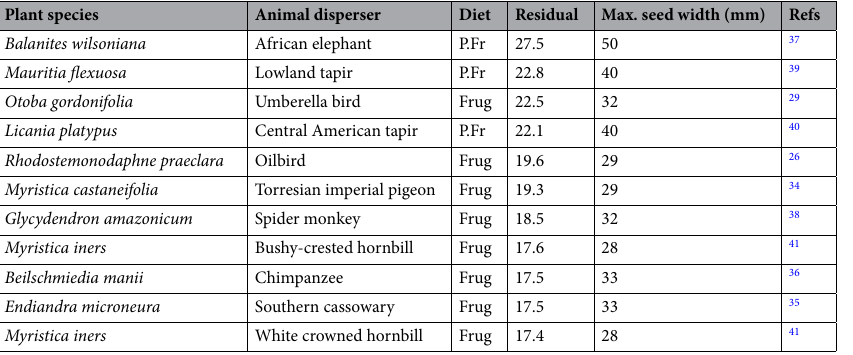
Figure. 2. Relationship between maximum width of endozoochorous dispersed seeds and the body weight of the disperser. ( A ) Whole dataset indicating the regression lines for frugivores, partial frugivores, and non-frugivores, indicating the dots for forest elephants and tapirs. ( B ) Only frugivores, indicating oilbirds, umbrellabirds, imperial pigeons, and a hornbill. Black lines indicate prediction intervals. Plant species Animal disperser Diet Residual Max. seed width (mm)